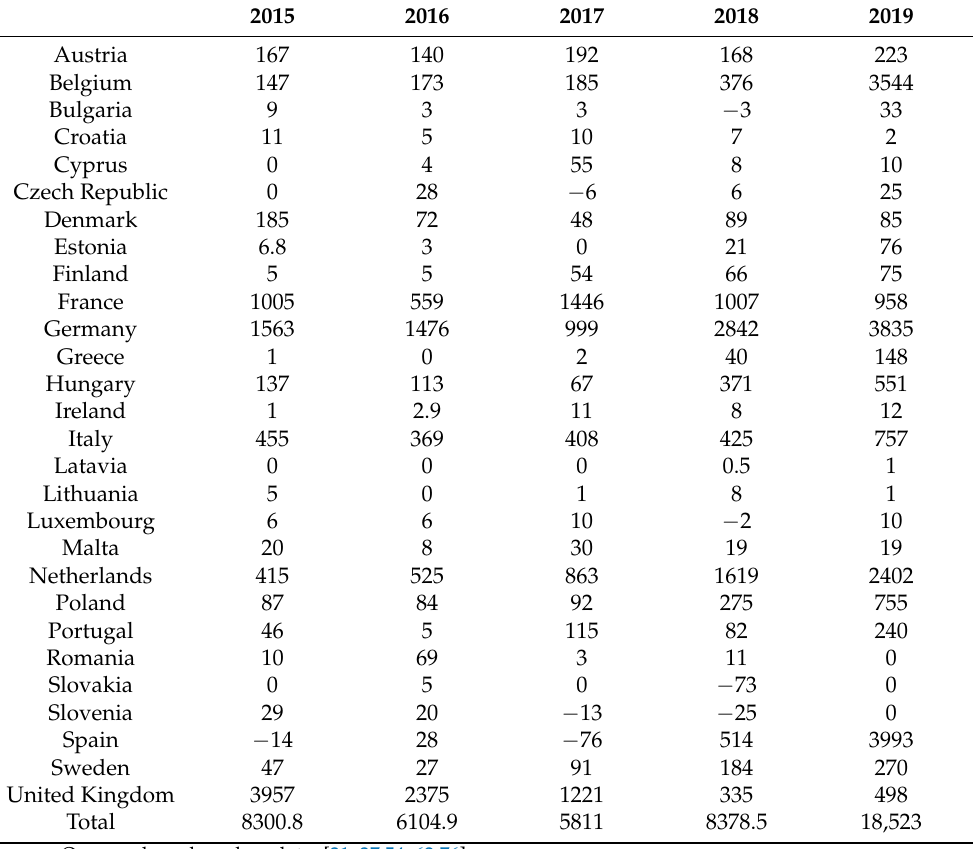
Table 4. Photovoltaic capacity installed in European Union countries in years 2015–2019